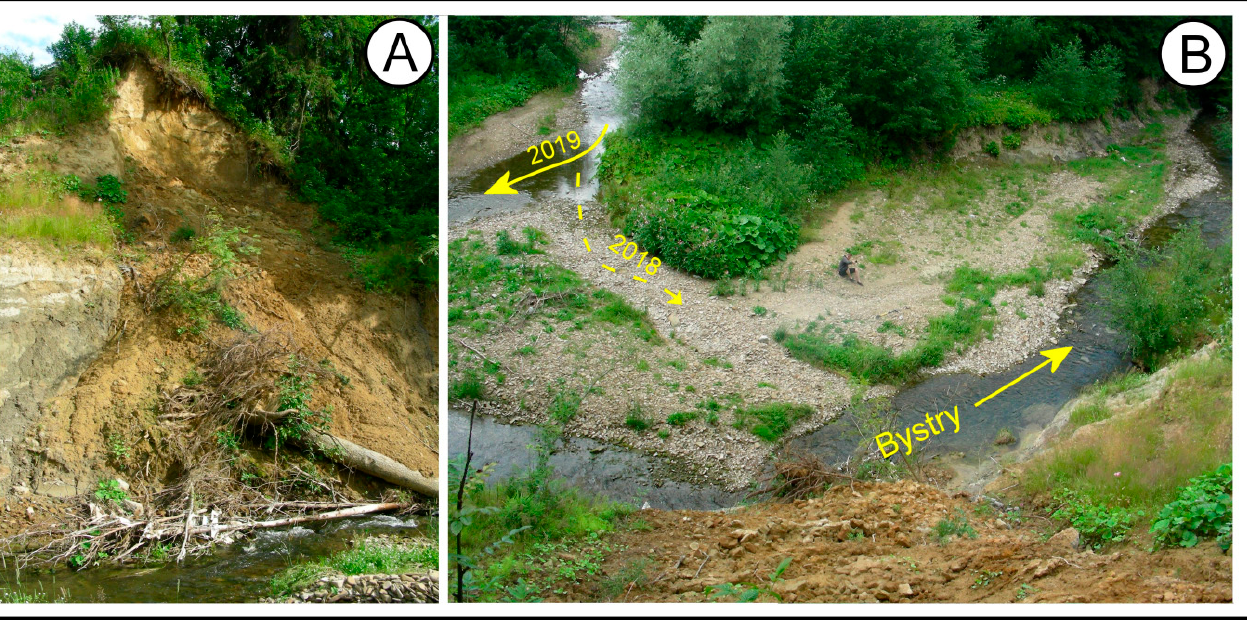
Figure 12. Rejuvenation of the landslide at section III ( A ) and rearrangement of the main flow of the river in 2019 ( B ) (site 3).